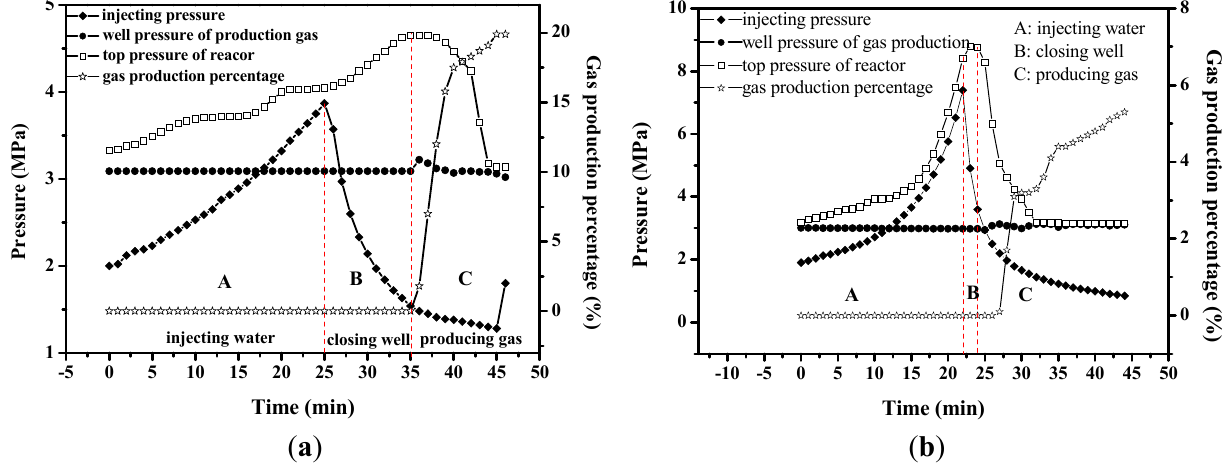
Figure 7. Variation of pressure and gas production rate with time at hydrate saturation of 0.293, hydrate sample temperature, hot-water temperature of 333.2 K, and well pressure of 3 MPa: ( a ) the first cycle; ( b ) the second cycle